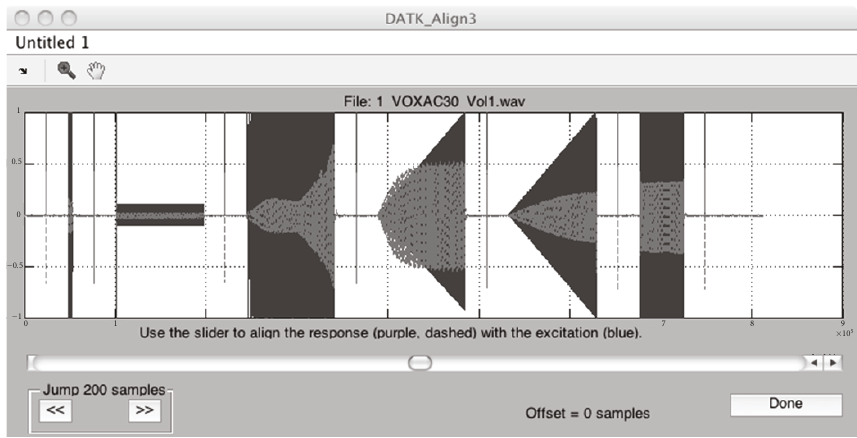
Figure 4: Graphical user interface for manual alignment of the analysis